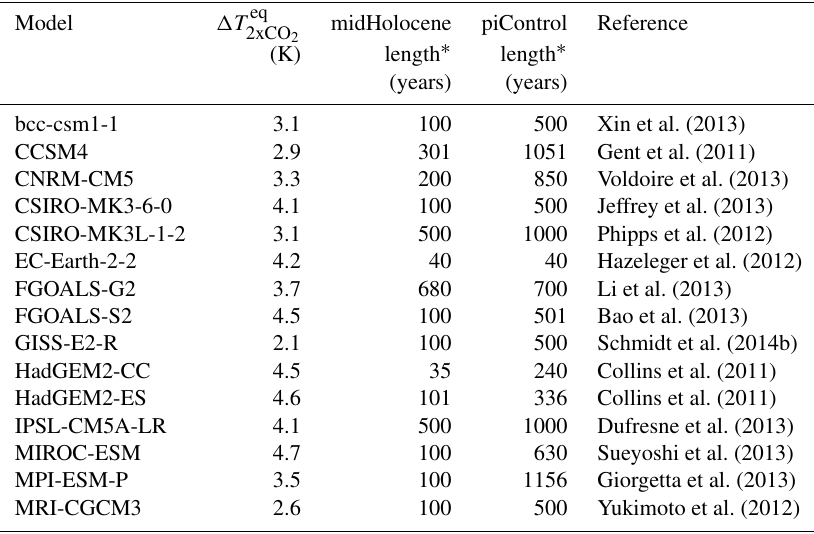
Table 2. Models contributing midHolocene simulations under CMIP5. See Table S1 for links to each individual simulation.